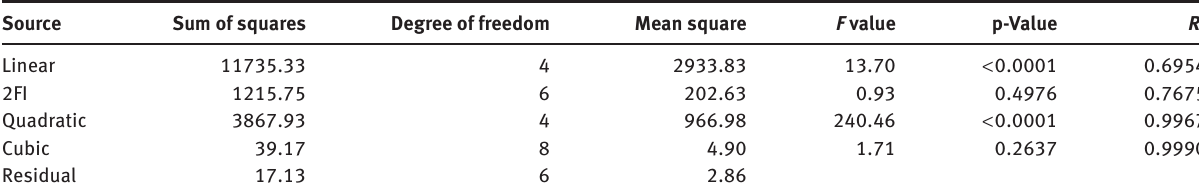
Table 4: Statistical parameters for sequential models.